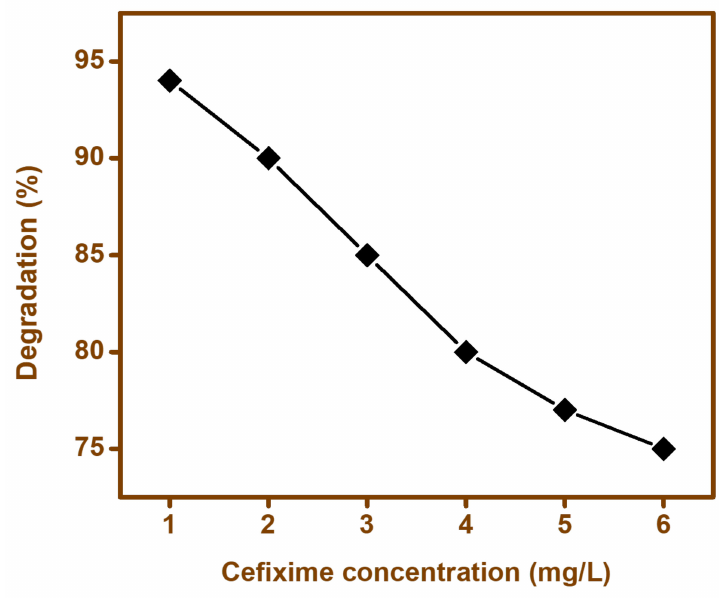
Figure 11. Effect of cefixime trihydrate concentration on the performance of BFO